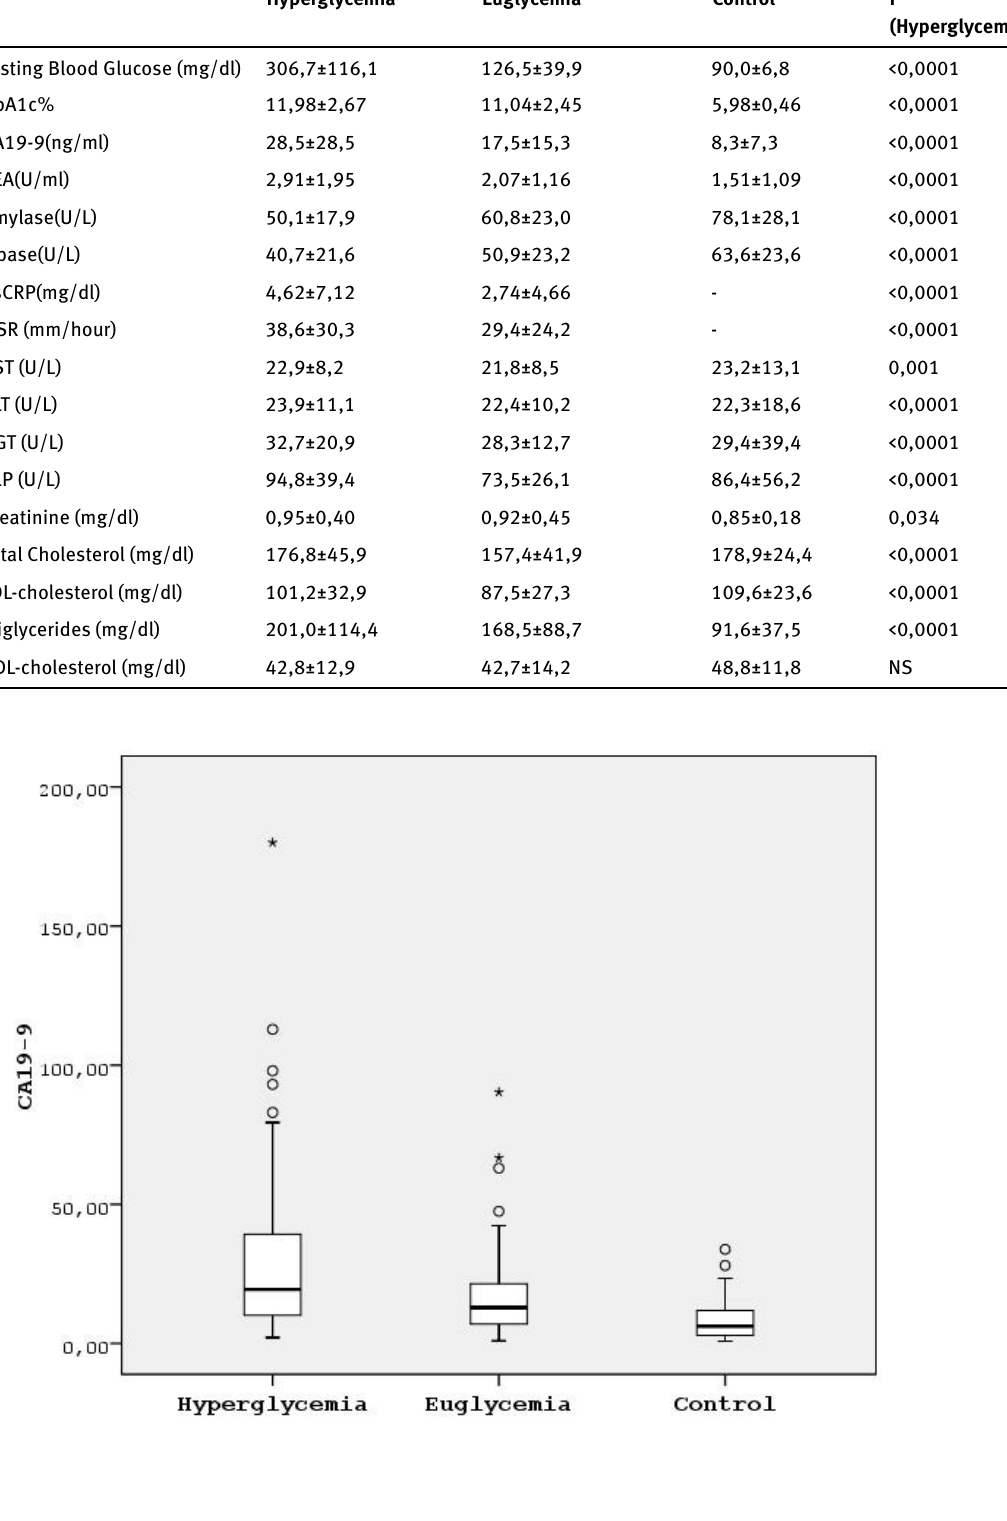
Figure 1: Comparison of CA19-9 levels between the